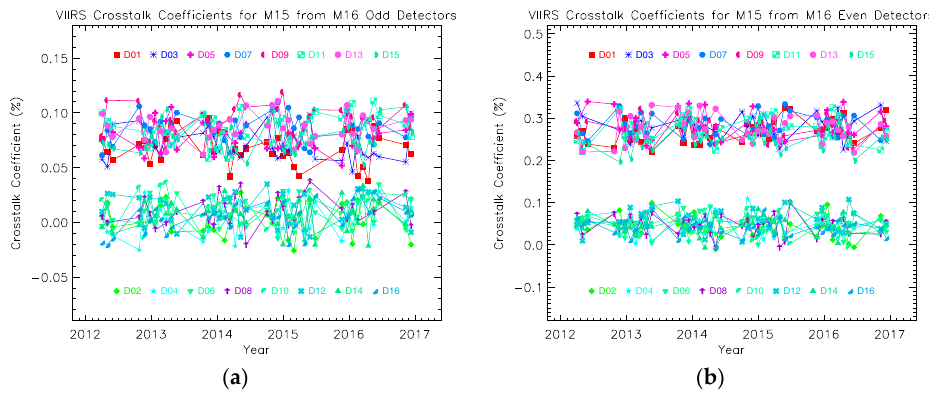
Figure 8. SNPP VIIRS Band M15 crosstalk coefficients for sending Band M16: ( a ) odd detectors and ( b ) even detectors.